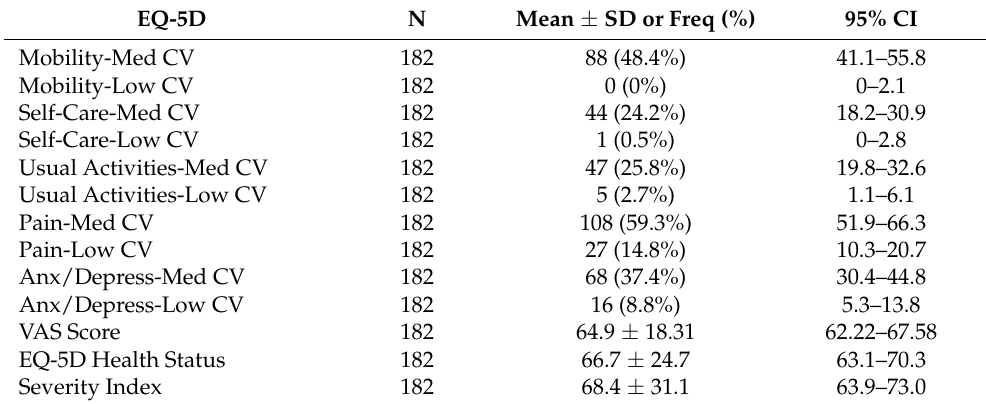
Table 2. EQ-5D. Results.